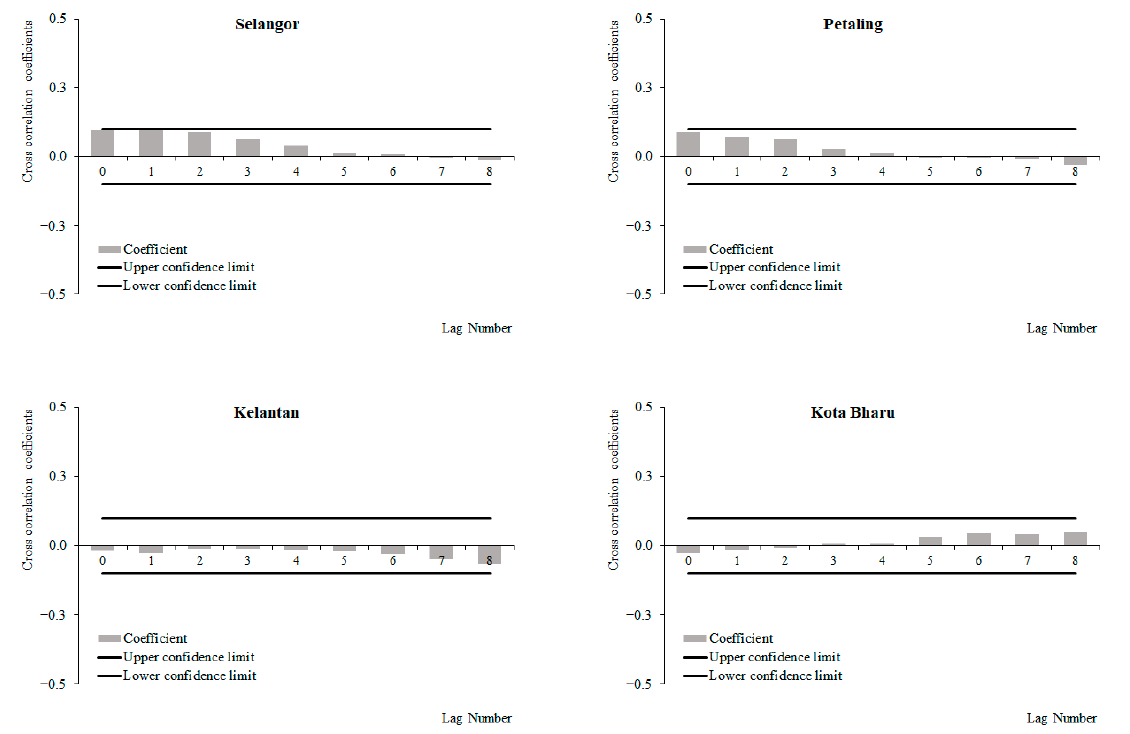
Figure 12. Cross-correlation function between dengue cases and wind speed in Selangor, Petaling, Kelantan and Kota Baharu, 2011 to 2019.